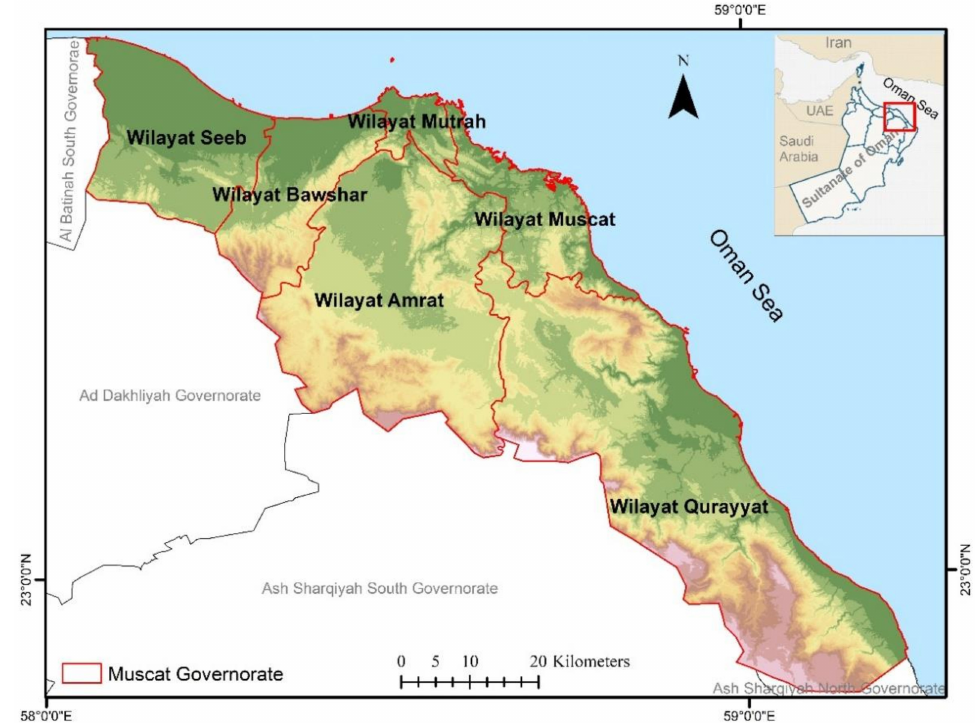
Figure 1. The location map of Muscat Governorate and its